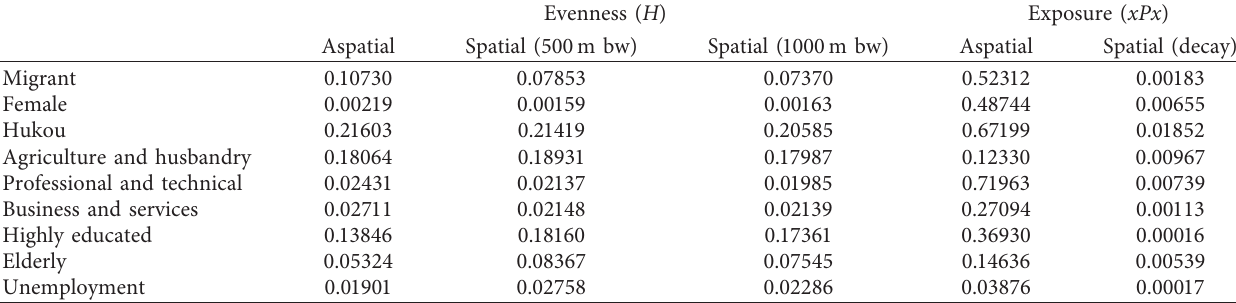
Table 1: Residential heterogeneity of different groups and dimensions in